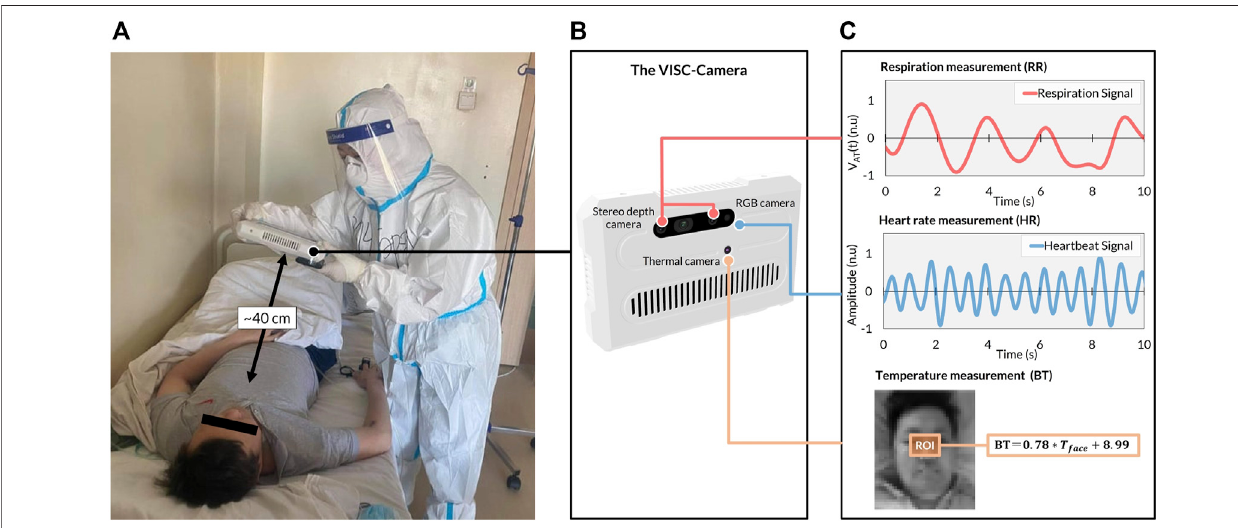
FIGURE 2 | The VISC-Camera structure and vital signs-related signals were derived in the COVID-19 isolation unit. (A) VISC-Camera screening for a patient with COVID-19 within 10 s (B) The three cameras of VISC-Camera: stereo depth camera for respiratory rate (RR) monitoring, RGB camera for heart rate (HR) determination, thermal camera for body temperature (BT) measurement. (C) Vital signs-related signals of the patient comprising respiration signal, heartbeat signal, and facial region of interest (ROI, orange rectangle) for BT determination.